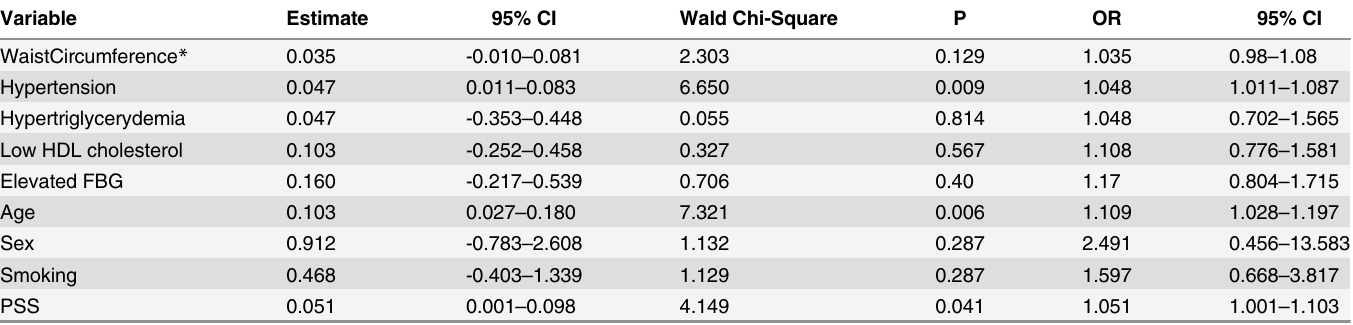
Table 4. Results of logistic regression analysis: odds ratios for coronary plaque prevalence according to MetS components adjusted for age, sex, smoking and perceived stress score. Variable